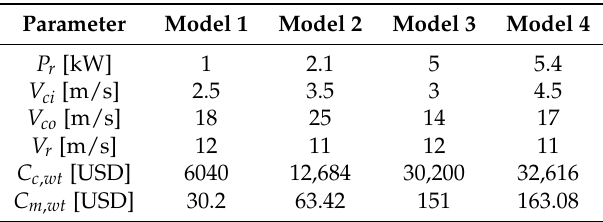
Table 3. Technical specifications of wind turbines [39–44].